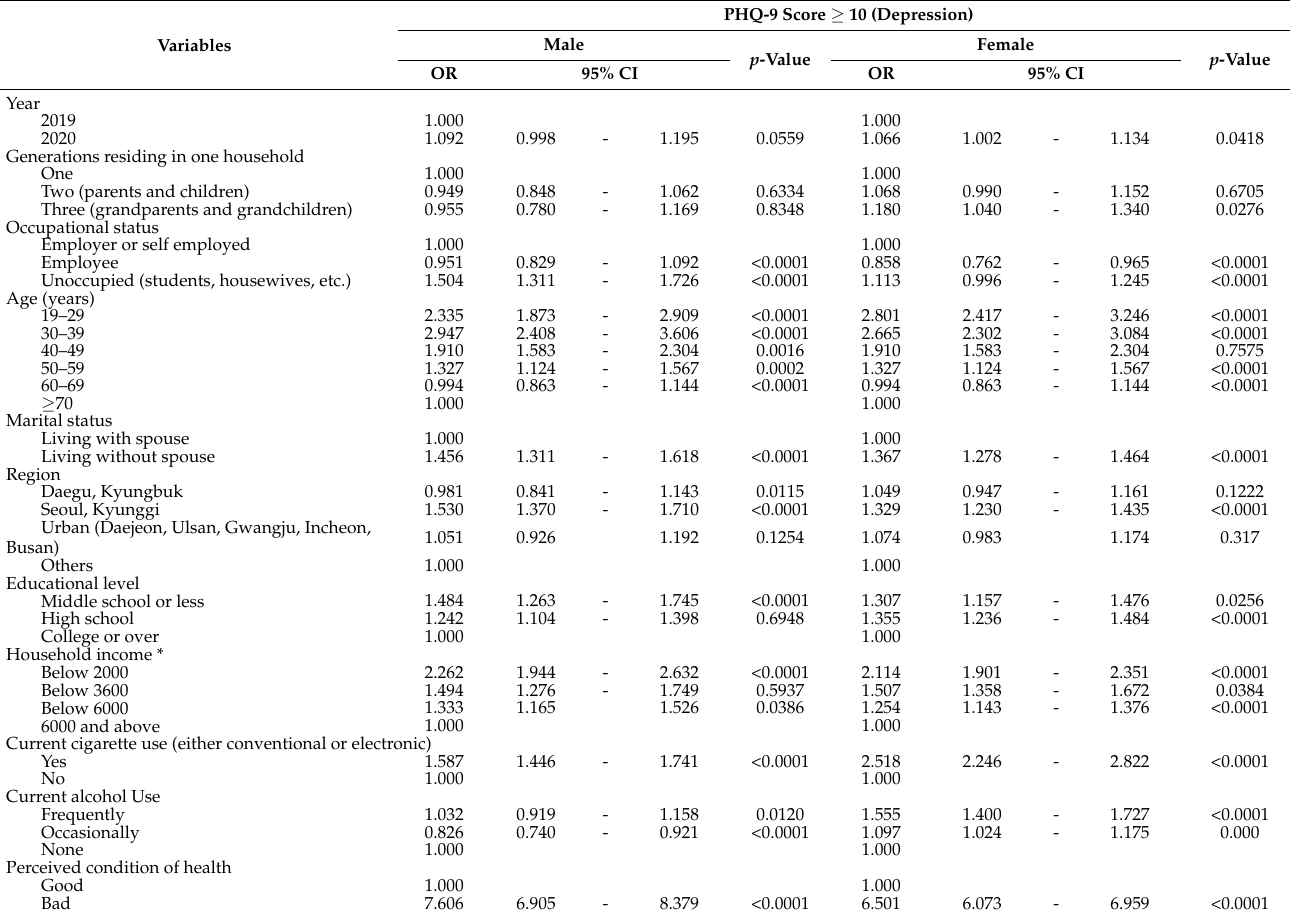
Table 2. Results of factors associated with depression by